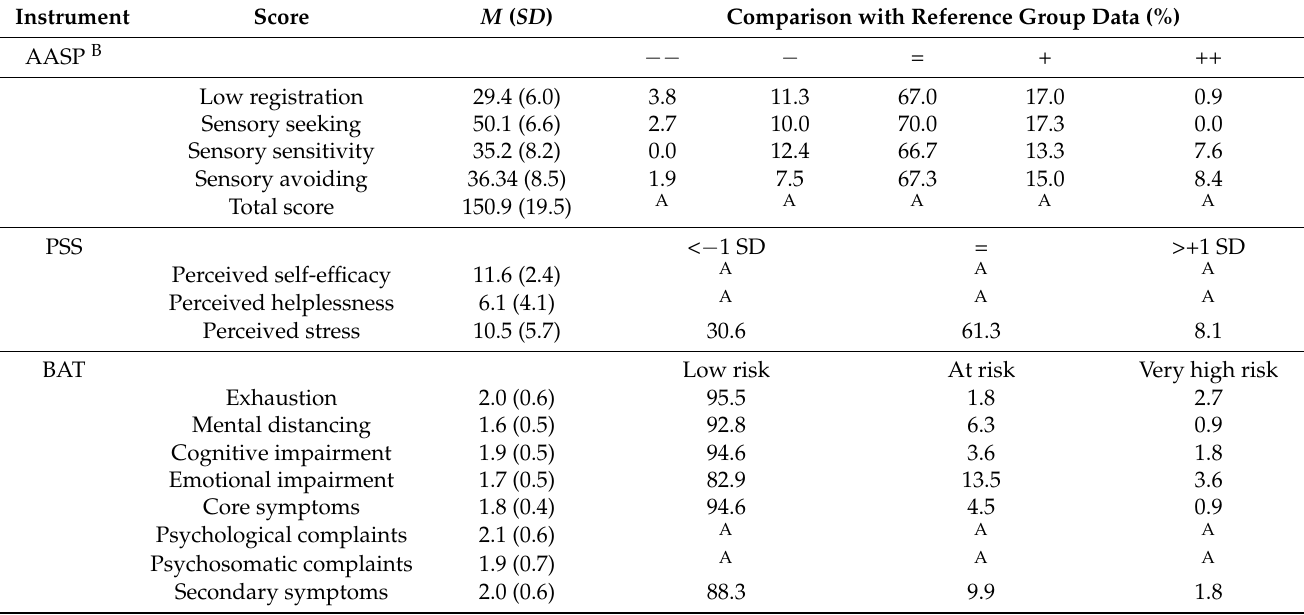
Table 2. Means and standard deviations of all involved total and subscale scores.